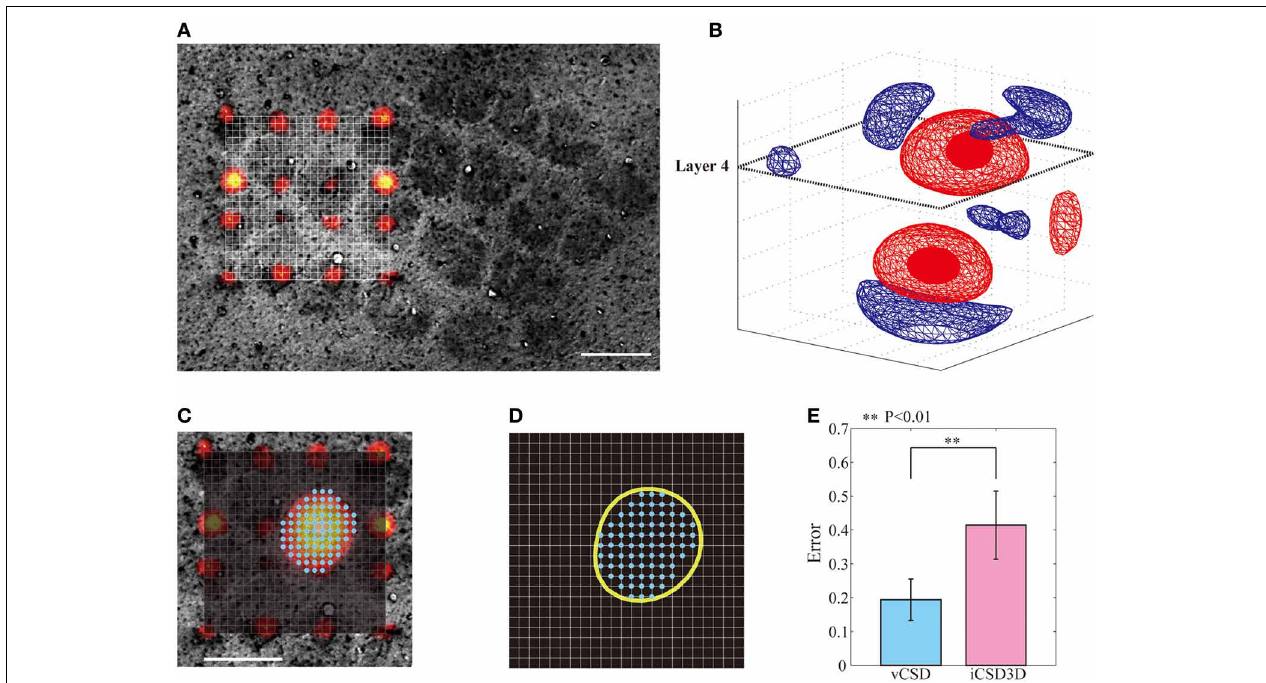
FIGURE 8 | Localization of barrels by means of the iCSD3D and vCSD methods. (A) CSD distribution at 6–8ms post-stimulus with an illustration of the xy -plane at the level of layer 4. (B) Co-registration of the xy -plane of the current source grid at the depth of layer 4 and the anatomical image acquired from the cytochrome c oxidase stained tangential brain section of the barrel cortex. The position of the shanks are determined from Dil staining images. (C) Superposed pictures in the xy -plane of the CSD